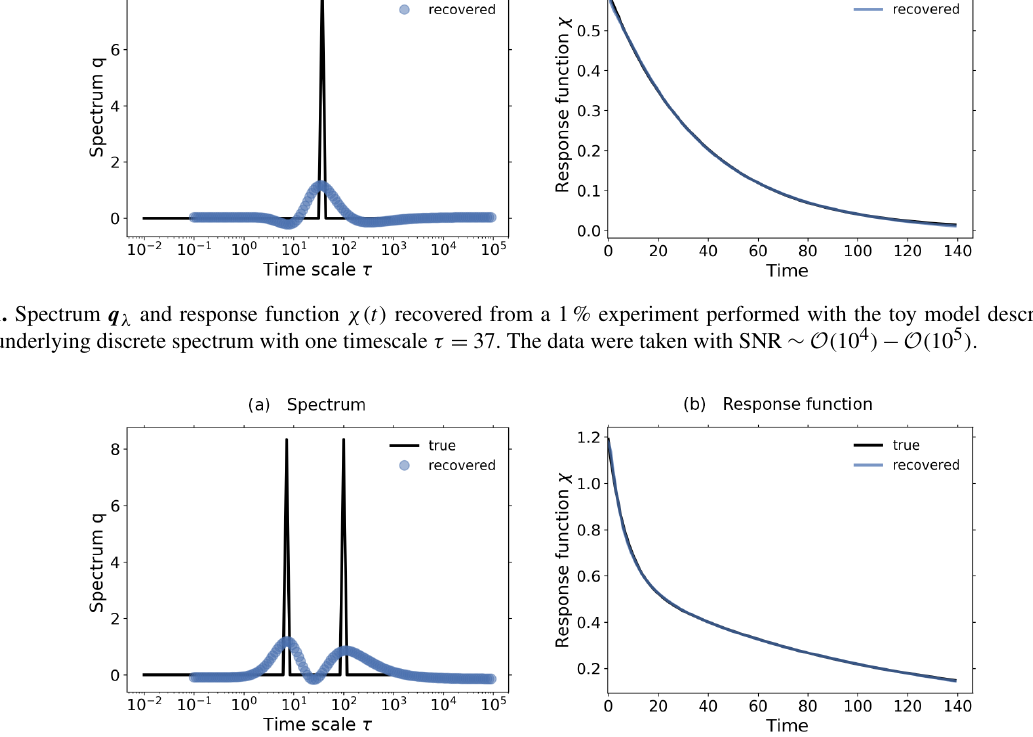
Figure E2. Spectrum q λ and response function χ(t) recovered from a 1% experiment performed with the toy model described in Part I taking an underlying discrete spectrum with two timescales τ = 7 and τ = 100. The data were taken with SNR ∼ O ( 10 4 ) − O ( 10 5 ) .